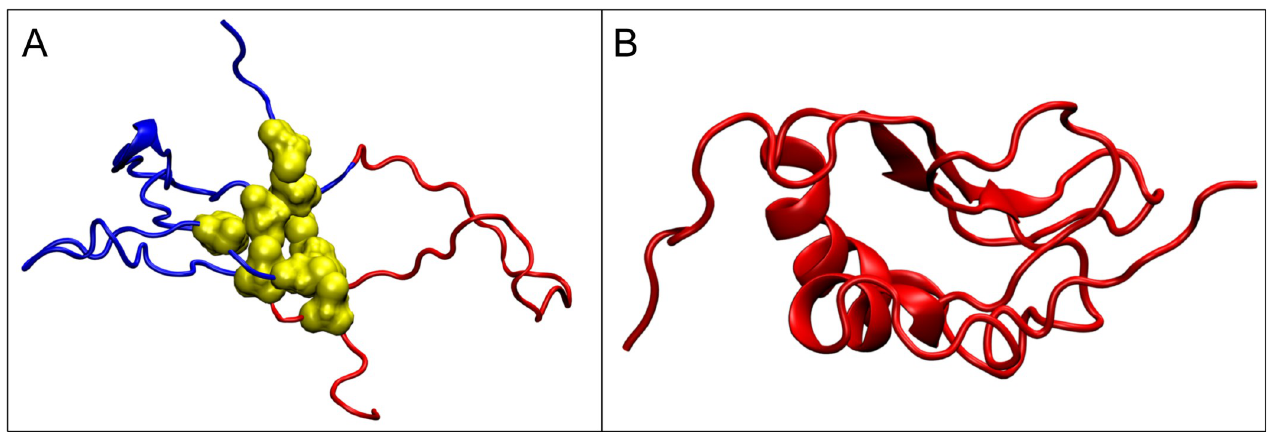
Fig 8. 3D presentation. A– 1DZ7 (yellow–Cys residues in disulfide bonds). B– 2L42 (red fragments–classified in DisProt as IDR).